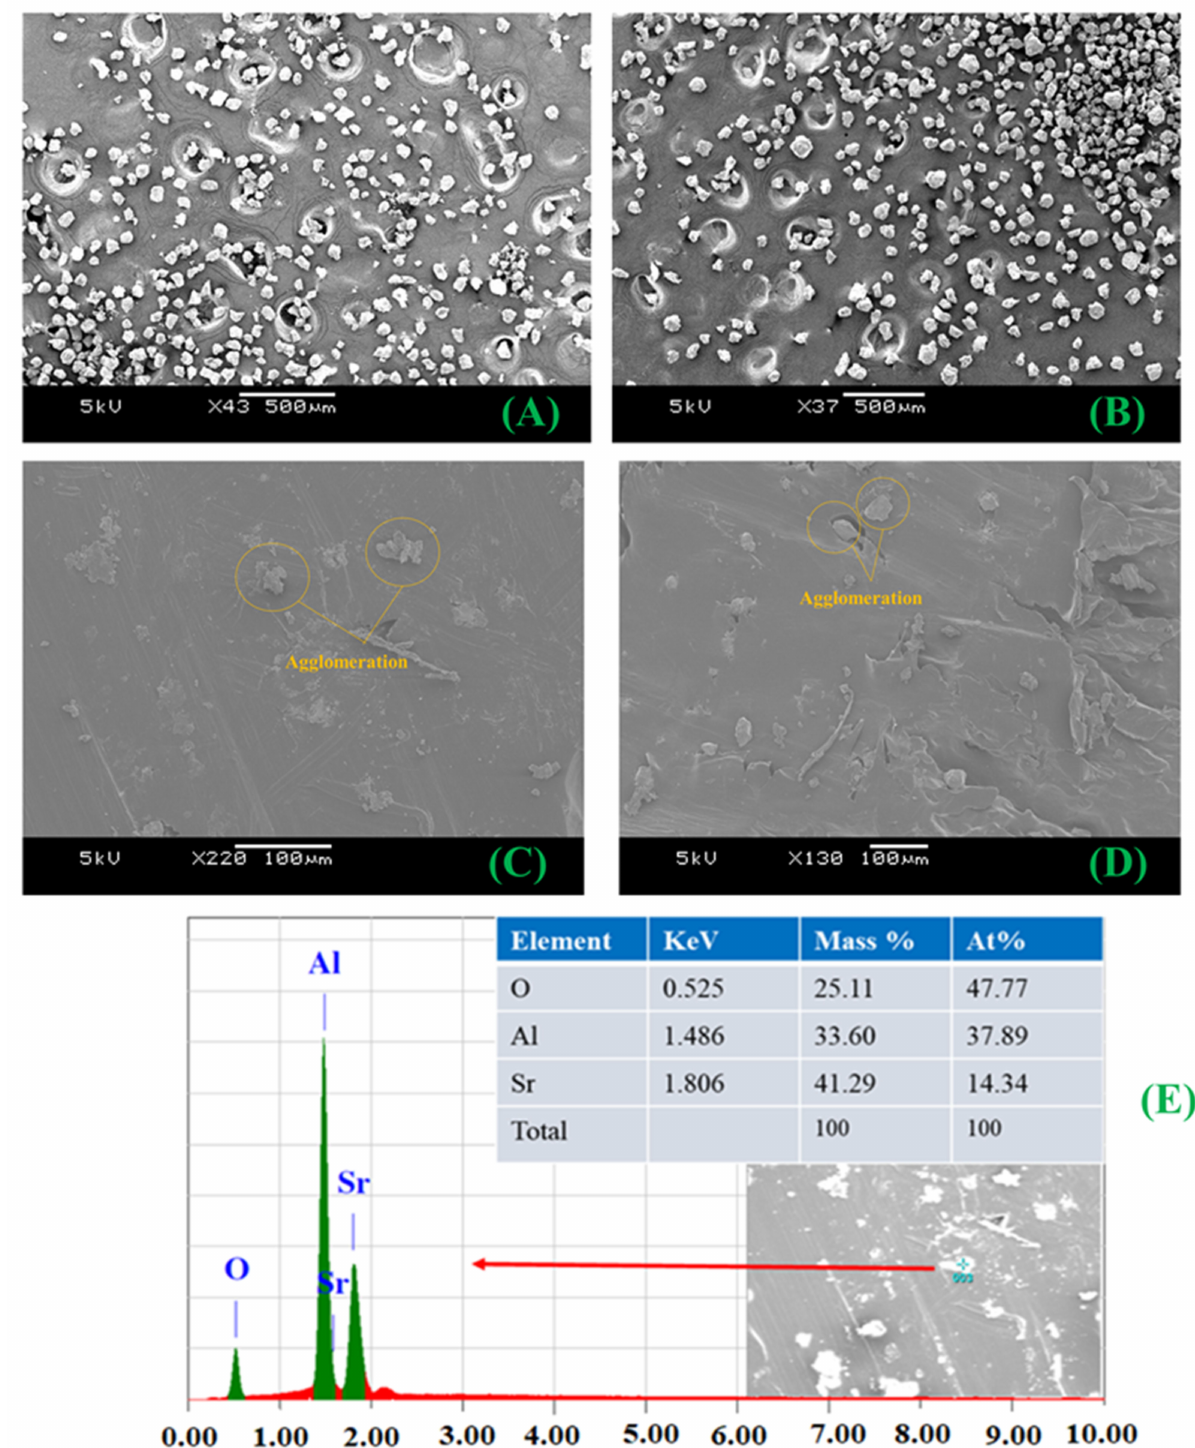
Figure 1. SEM images of AG 1 ( A ) and AG 2 ( B ) powders; and HDPE/10AG 1 ( C ), HDPE/10AG 2 ( D ), and EDS of HDPE/10AG 1 ( E )